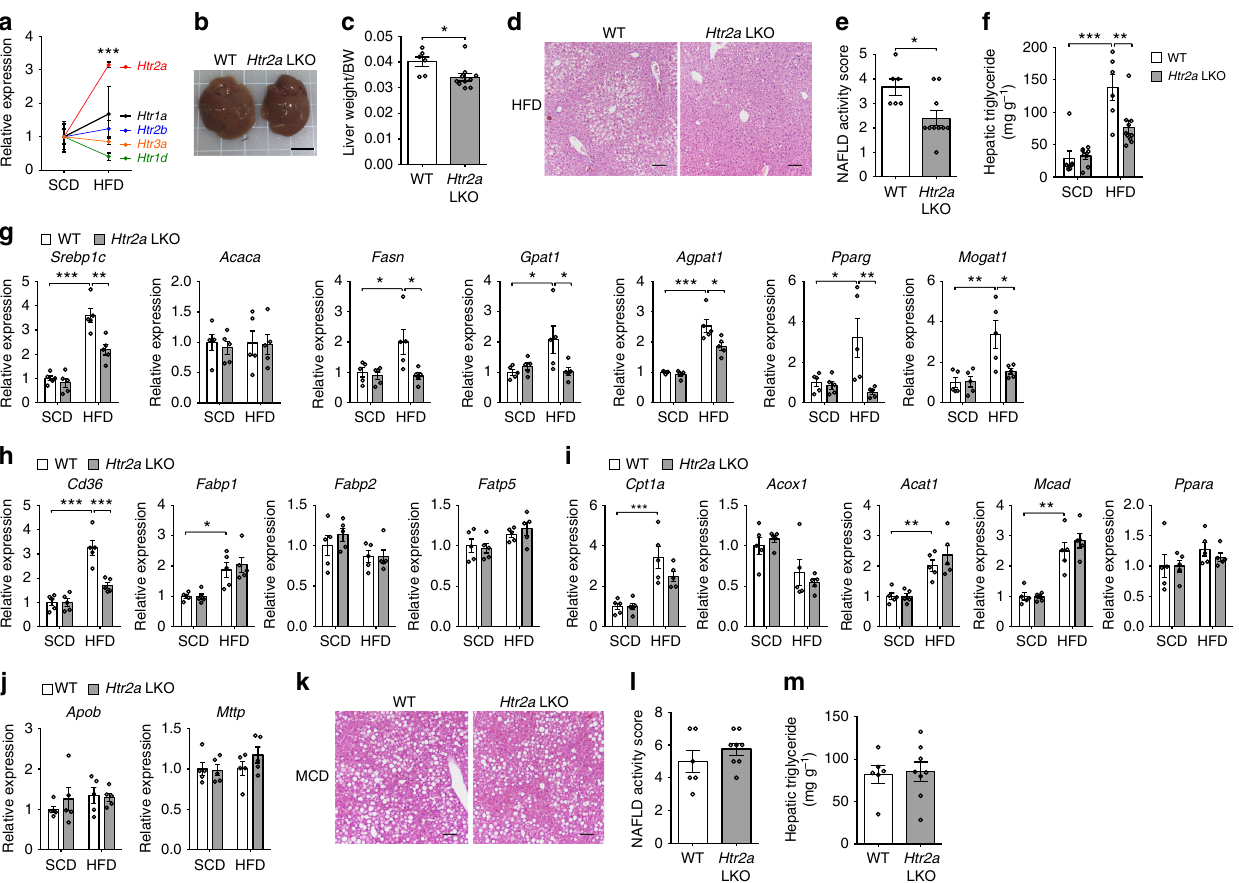
Fig. 4 HTR2A mediates the lipogenic action of GDS in the liver. a Relative mRNA expression of indicated HTRs as assessed by qRT-PCR in liver of SCD- and HFD-fed C57BL/6J mice; n = 4 per group. b – j The 12-week-old WT and Htr2a LKO mice were fed SCD or HFD for 8 weeks. Representative gross liver image ( b ) and liver weight ( c ) of HFD-fed WT and Htr2a LKO mice; n = 6 – 10 per group. Scale bar, 1 cm ( b ). d Representative liver histology by H&E staining from HFD-fed WT and Htr2a LKO mice. Scale bars, 100 μ m. e NAS of HFD-fed WT and Htr2a LKO mice; n = 6 – 10 per group. f Hepatic triglyceride levels; n = 6 – 10 per group. g – j Relative mRNA expression of genes involved in lipogenesis ( g ), FA uptake ( h ), FA oxidation ( i ), and VLDL secretion ( j ) as assessed by qRT-PCR in liver; n = 5 per group. k – m The 8-week-old WT and Htr2a LKO mice were fed MCD diet for 6 weeks. k Representative liver histology by H&E staining. Scale bars, 100 μ m. l NAS; n = 6 – 8 per group. m Hepatic triglyceride levels; n = 6 – 8 per group. Data are expressed as the